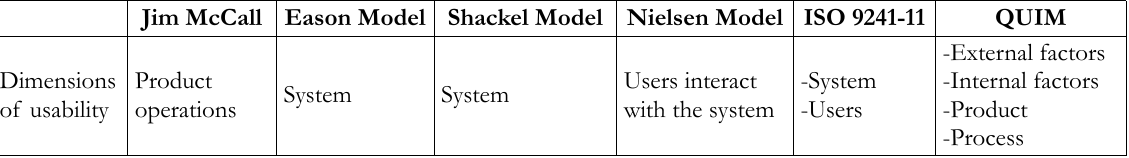
Table 2. The dimensions of usability that are considered in the previous